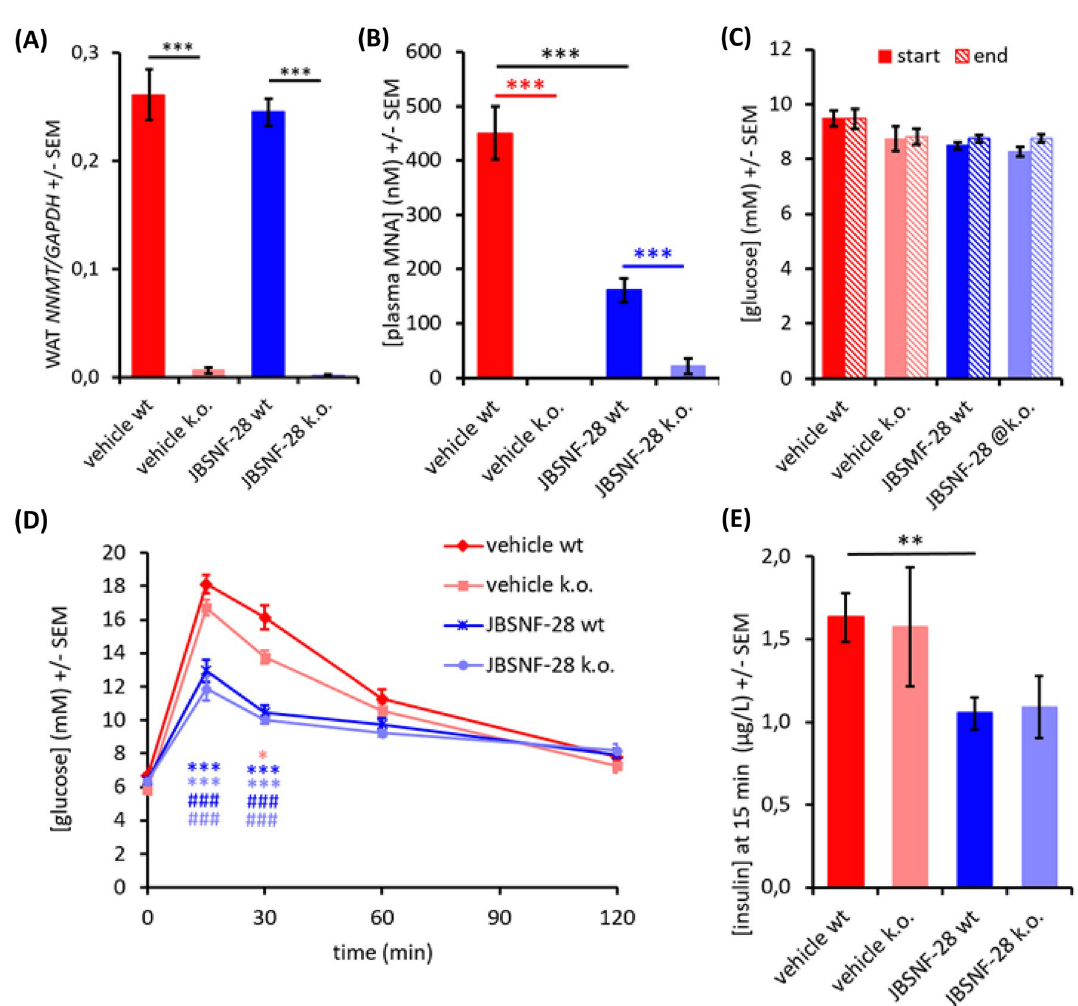
Figure 8. Effect of 4-w treatment with JBSNF-000028 (50 mg kg − 1 bid) in NNMT knockout animals on HFD. ( A ) NNMT expression in white adipose tissue of wild-type and NNMT knockout mice. ( B ) Plasma MNA concentrations in wild-type or knockout animals with or without treatment with JBSNF-000028. ( C ) Plasma glucose concentrations under fed conditions before (filled columns) and after (hatched columns) four weeks of treatment with JBSNF-000028. ( D ) Oral glucose tolerance test after four weeks of treatment with JBSNF-000028. ( E ) Plasma insulin levels 15 min after oral glucose bolus in the glucose tolerance test. * p < 0.05, ** p < 0.01; *** p < 0.001 versus the other indicated column. ( D ) * p < 0.05 wild-type vs knockout (vehicle-treated), *** p < 0.001 for JBSNF-000028 treated wild-type (dark blue) or knockout (light blue) animals vs. vehicle-treated wild-type mice. ### p < 0.001 for JBSNF-000028 treated wild-type (dark blue) or knockout (light blue) animals versus vehicle-treated knockout